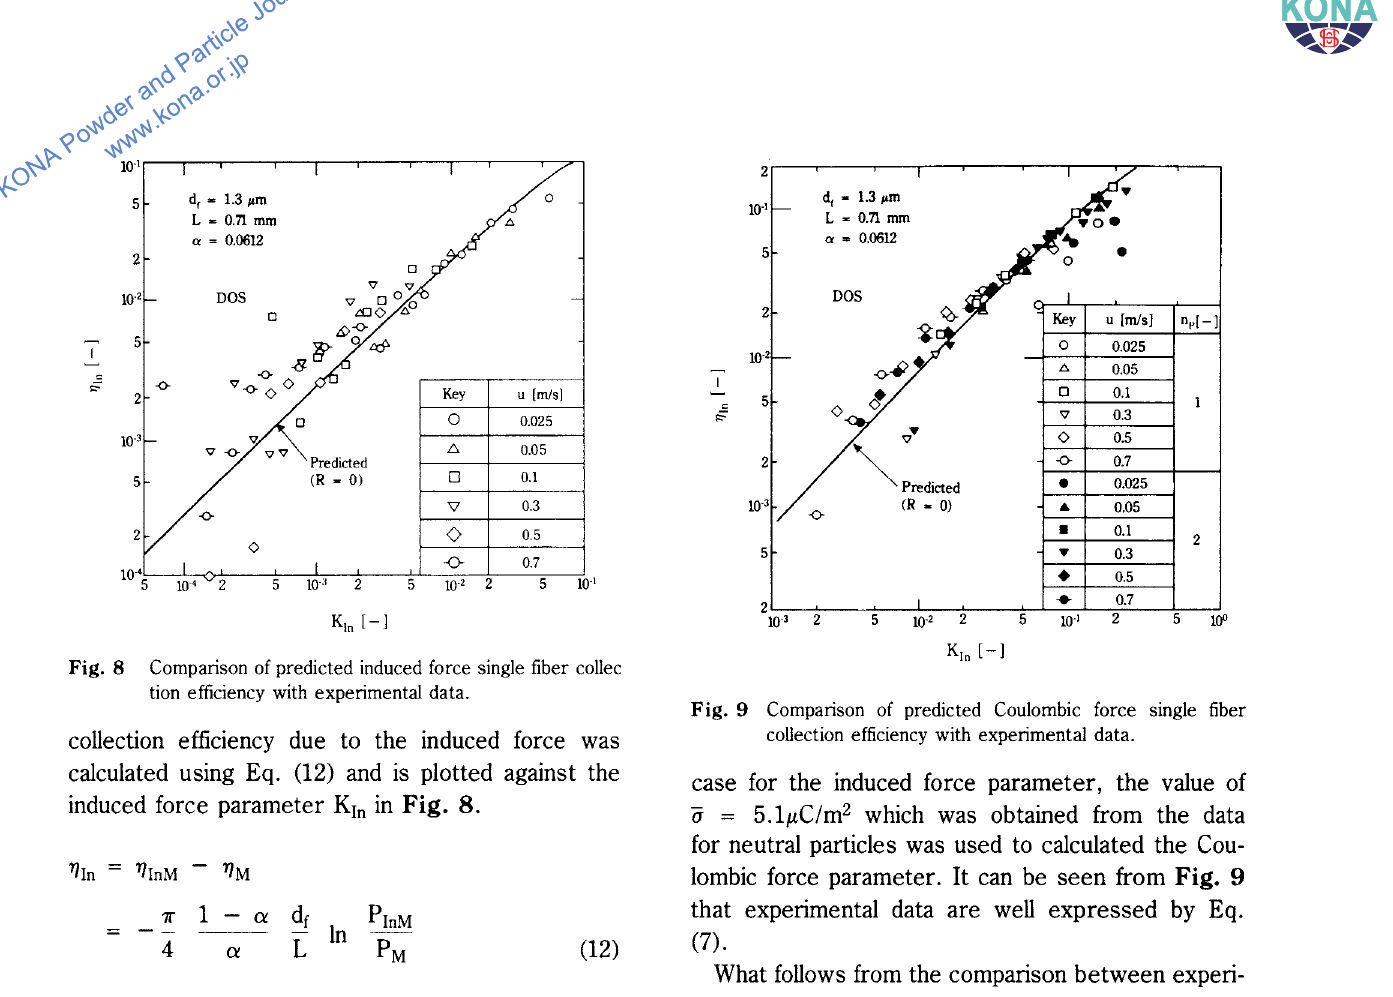
Fig. 8 Comparison of predicted induced force single fiber collec tion efficiency with experimental data. Fig. 9 Comparison of predicted Coulombic force single fiber collection efficiency with experimental data. collection efficiency due to the induced force was calculated using Eq. (12) and is plotted against the case for the induced force parameter, the value of induced force parameter K in Fig. 8. a = 5.1ttC/m 2 which was obtained from the data 1 n for neutral particles was used to calculated the Cou lombic force parameter. It can be seen from Fig. 9 that experimental data are well expressed by